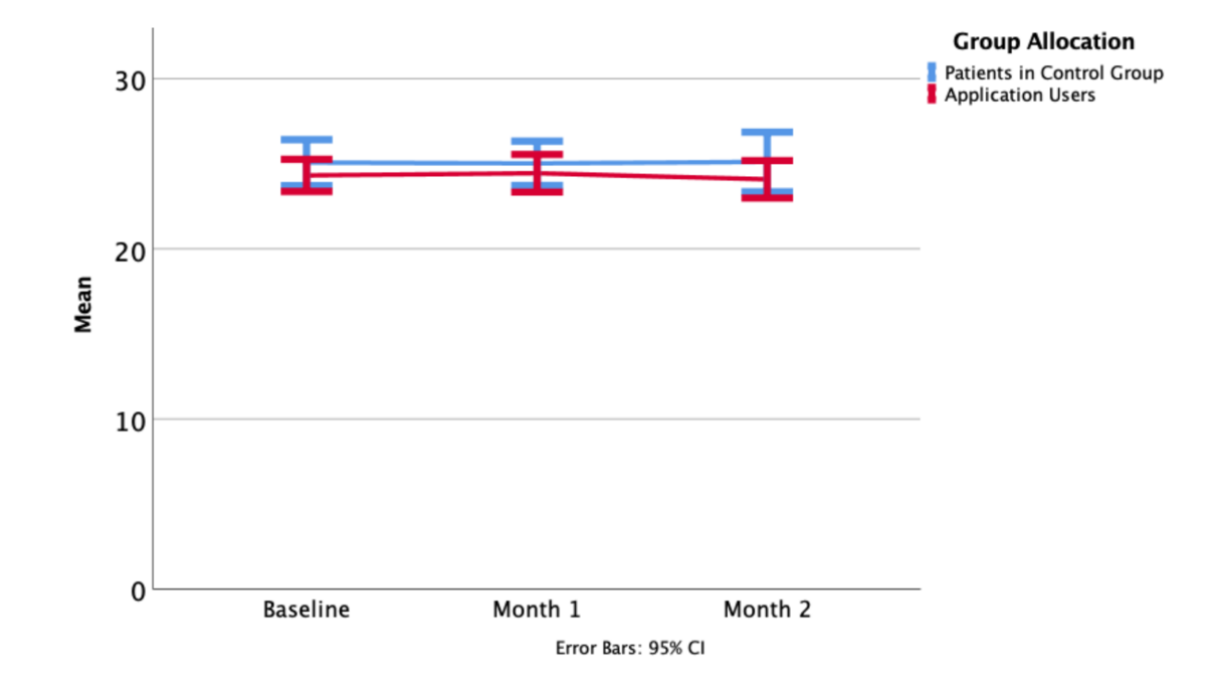
Figure 5. General version of the Functional Assessment of Cancer Therapy (FACT-G) Social and Family wellbeing subscore means at baseline, one month, and at the end of the study